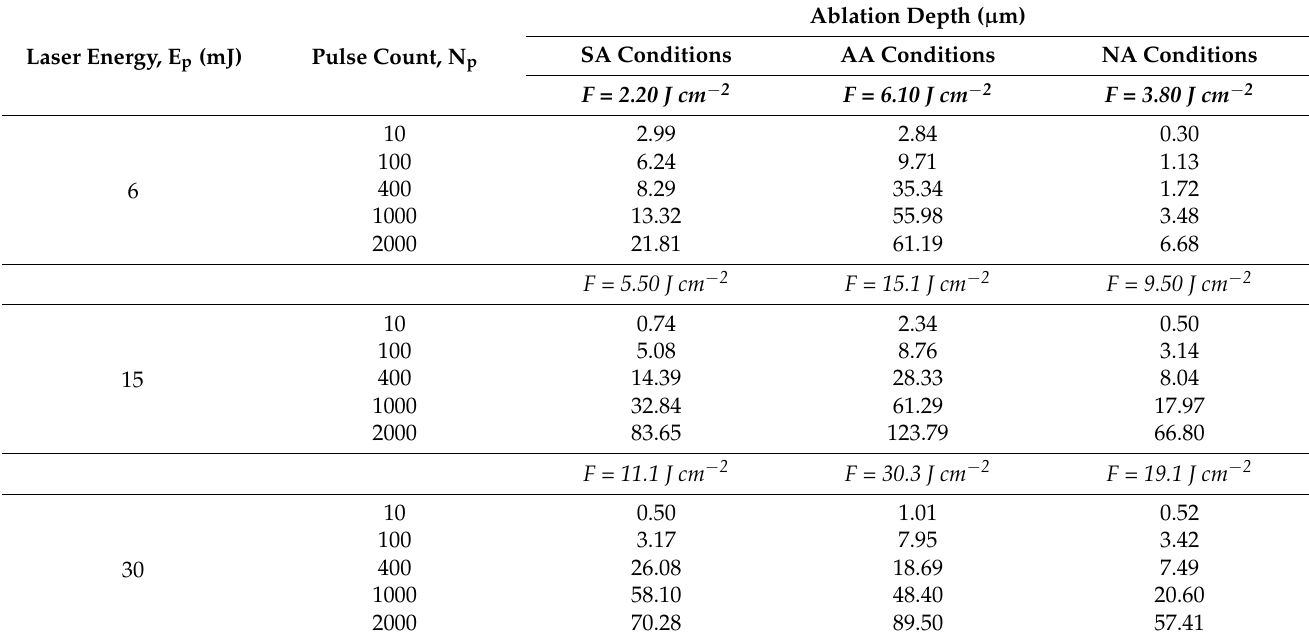
Table 2. Values of ablation depth after the irradiation of Nimonic 263 surface with picosecond laser by changing the laser parameters and environmental